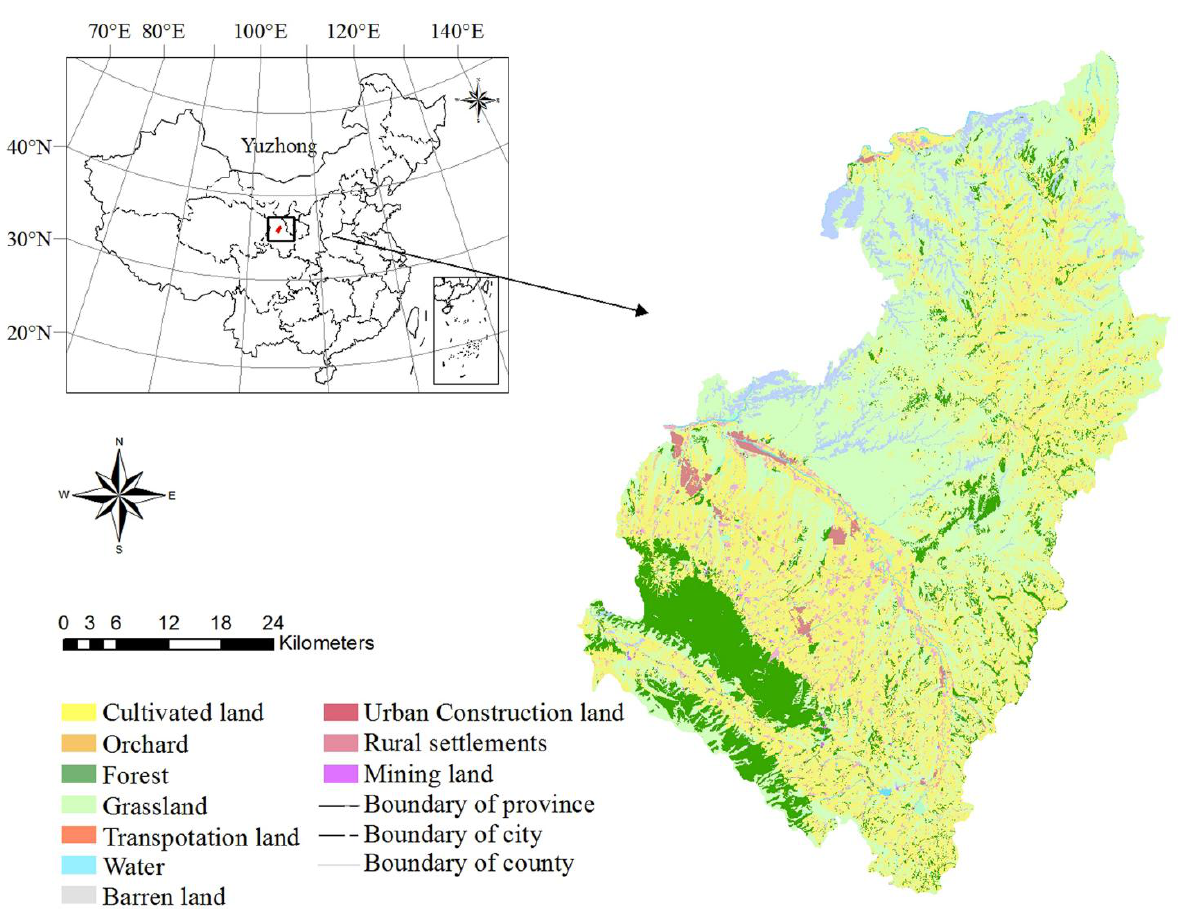
Figure 2. Location of Yuzhong